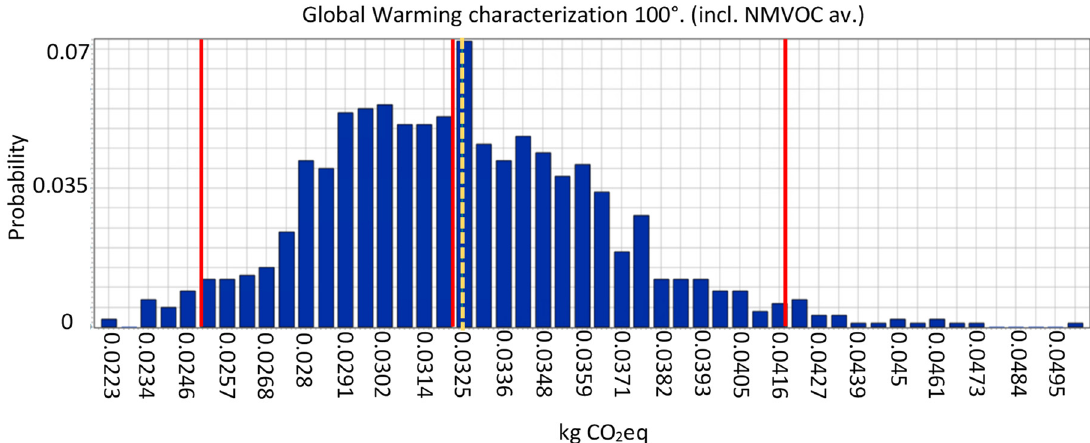
Figure 8. Monte Carlo graphical representation of distribution for the impact category “Global warming”. The horizontal axis displays the value of the calculation, the vertical axis displays the probability that a certain value is reached. The first and the last red lines represent the boundaries of the 95% confidence interval. The dotted orange line and the red line next to it are respectively the mean and the median values.